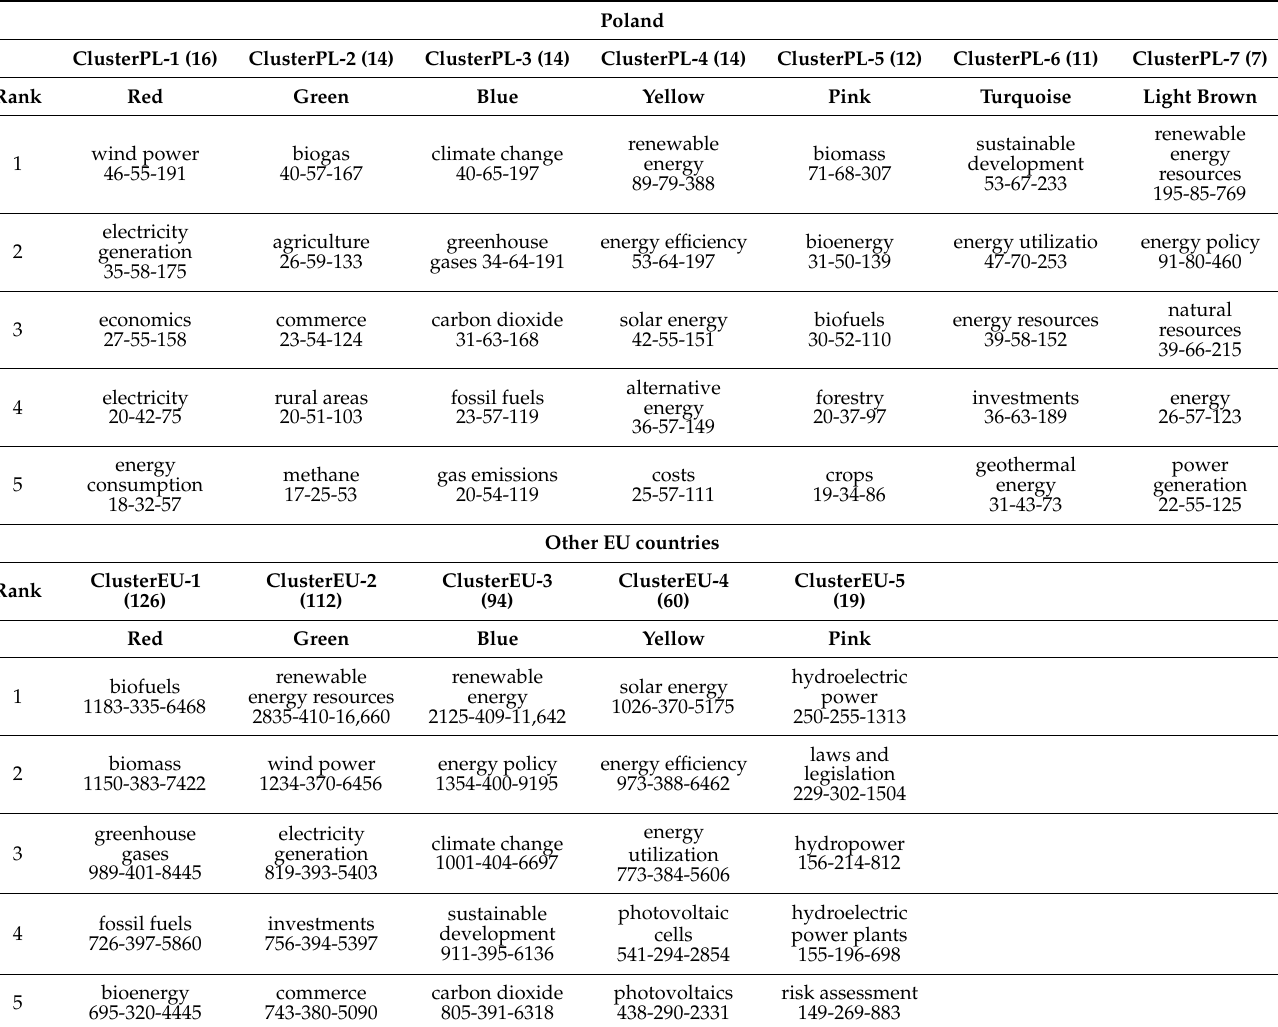
Table 8. The most common keywords from RE research (Scopus,